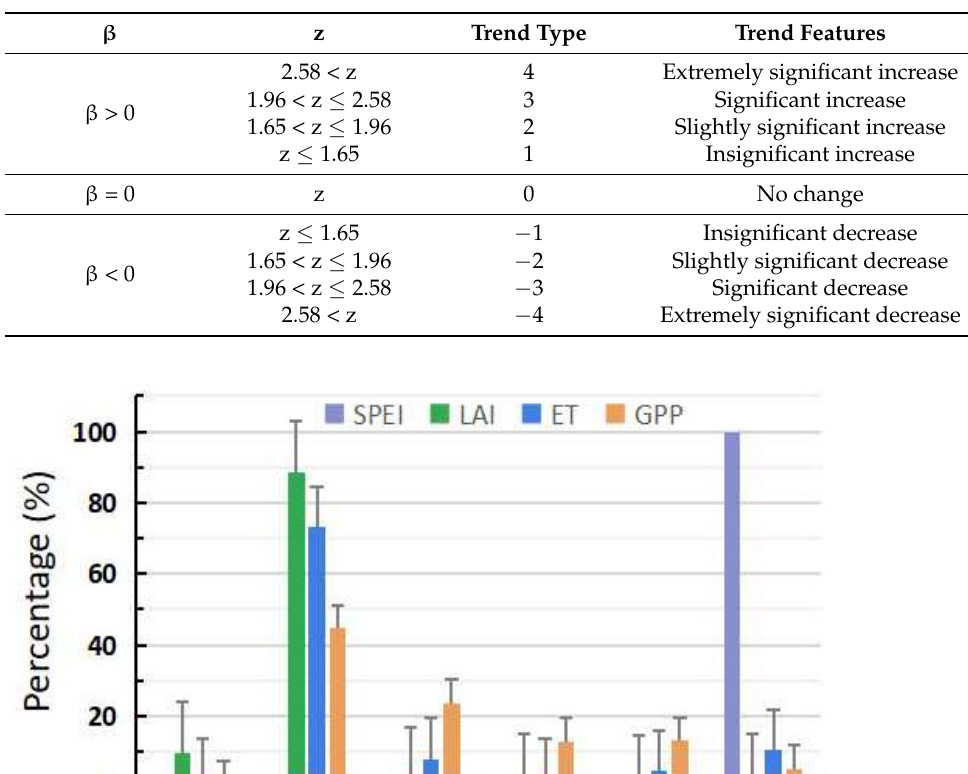
Table 1. Change trend types of four variables.